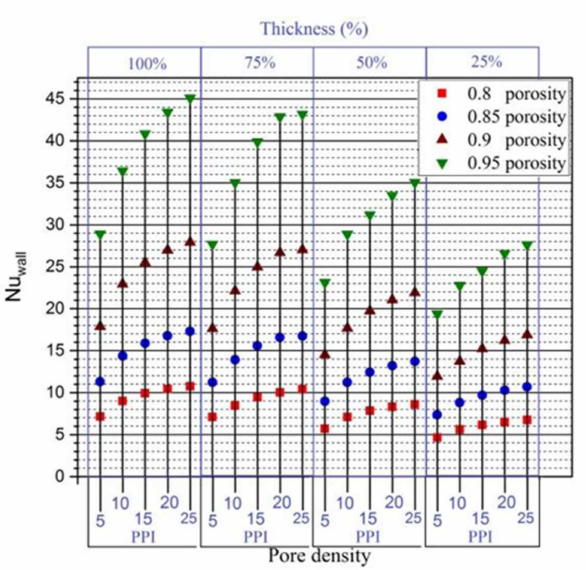
Figure 7. Variation of wall Nusselt number for varying thickness scenarios at various pore density and porosity conditions.